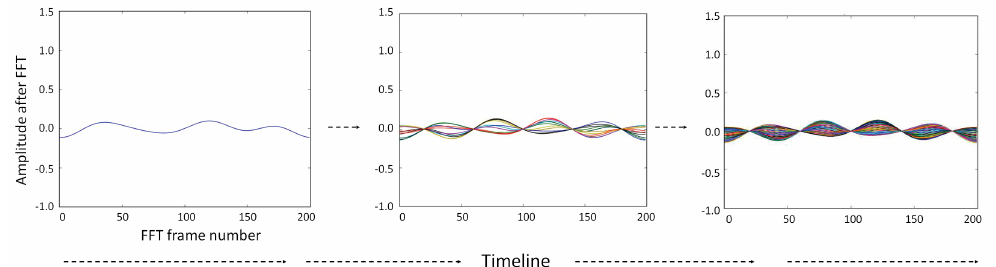
Figure 7. Users performed the same activities in a different order over a time